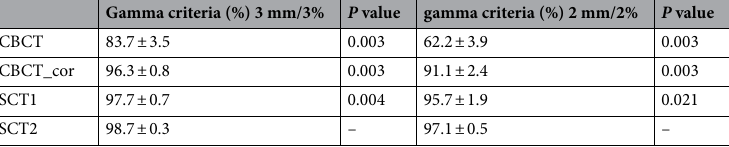
Table 3. 3D gamma analysis of the CBCT, CBCT_cor, SCT1 and SCT2 compared with RCT (mean ±